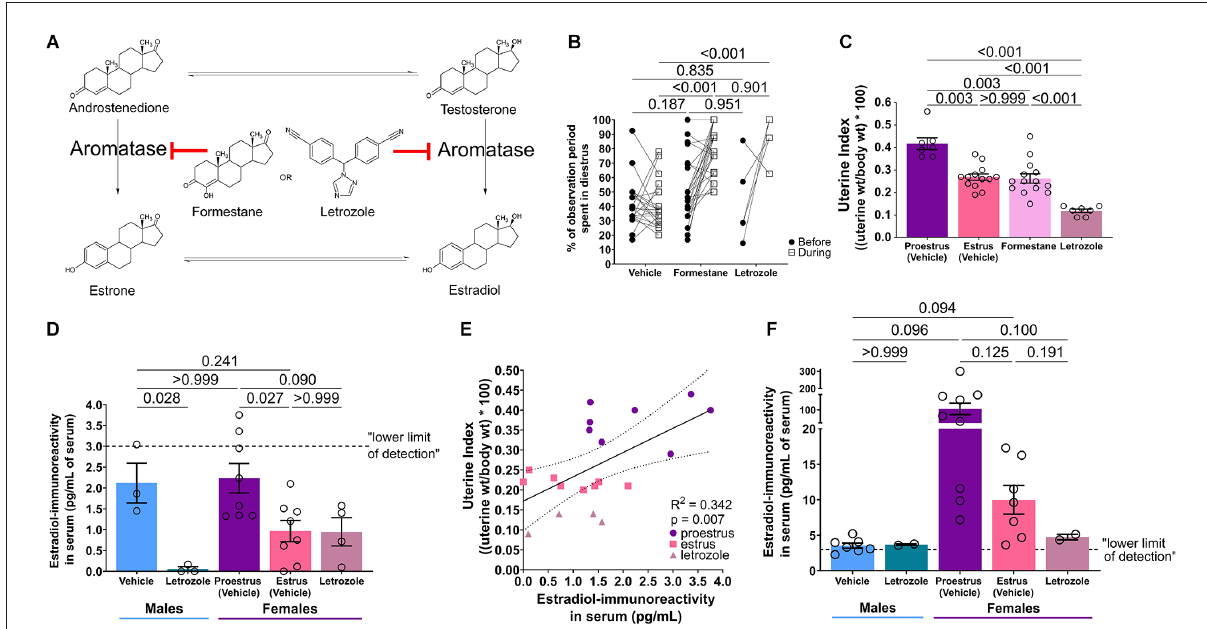
FIGURE2 Aromatase inhibition disrupts estrous cycling and decreases systemic estradiol levels. (A) Aromatase inhibitors, formestane and letrozole, block the conversion of androgens to estrogens. (B) During treatment, aromatase inhibitors increase the percentage of time the female mouse spends in the diestrus phase of the cycle ( n = 7–24/group). (C) Uterine indices are decreased in estrus compared to proestrus mice. Treatment with aromatase inhibitors likewise decreases uterine indices ( n = 7–14/group). (D) Estradiol-immunoreactivity was quantified in serum directly measured by ELISA (unextracted). Letrozole treatment tended to decrease estradiol levels and proestrus levels were elevated compared to estrus. However, male vehicle serum estradiol levels were high, similar to proestrus female levels. Most values are below the lower limit of detection of the assay ( n = 3–8/group). (E) There is a positive correlation between estradiol-immunoreactivity in serum measured by ELISA and uterine index in female mice ( n = 20). (F) Estradiol-immunoreactivity was additionally quantified in serum that was extracted prior to ELISA. Again, letrozole treatment tended to decrease estradiol levels and proestrus levels were elevated, though with even larger variability, compared to estrus. With extraction, male serum estradiol levels were below female ( n = 2–9/group). Post test p-values are provided above the corresponding comparisons. Individual points represent individual mice and matched points represent a mouse at different time points. Data are presented as mean ±